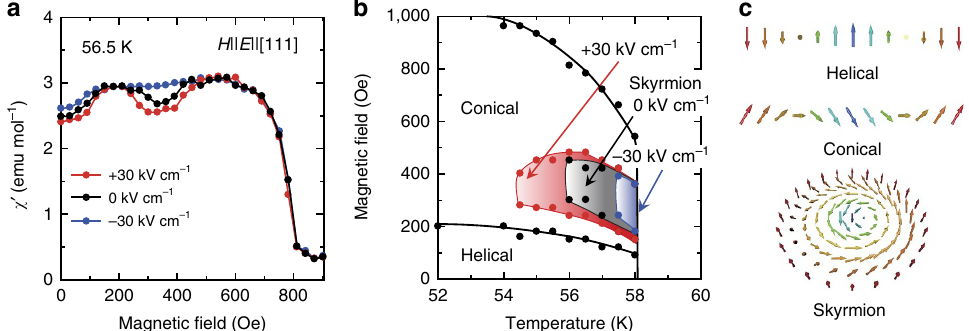
Figure 1 | Electric field variation of the thermodynamic stability of the skyrmion phase. ( a ), The magnetic field dependence of the a.c. susceptibility, w ’ , under various electric fields of (cid:2) 30 (blue), 0 (black), and þ 30kVcm (cid:2) 1 (red). ( b ), The magnetic phase diagram near the transition temperature under electric fields of (cid:2) 30 (blue), 0 (black), and þ 30kVcm (cid:2) 1 (red). Sign of electric field is defined as parallel ( þ ) and anti-parallel ( (cid:2) ) to the magnetic-field direction. ( c ), Schematics of helical, conical and skyrmion structures. The helical region in the phase diagram comprises multi-domains with different wave vectors ( q ’s) of spin helix, while the conical region represents the single q -state helix along the magnetic-field